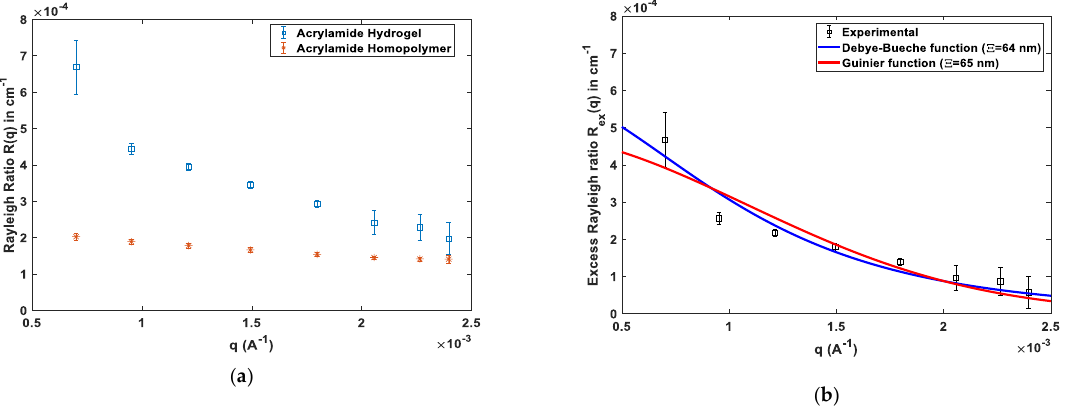
Figure 11. ( a ) Experimental data relative to the SLS analysis of a polyacrylamide hydrogel and the analogous polyacrylamide homopolymer (Rayleigh ratios at different scattering angles for H7 and L5). ( b ) Measured excess Rayleigh ratio for hydrogel H7 and data fitted using the Debye-Bueche and Guinier functions.